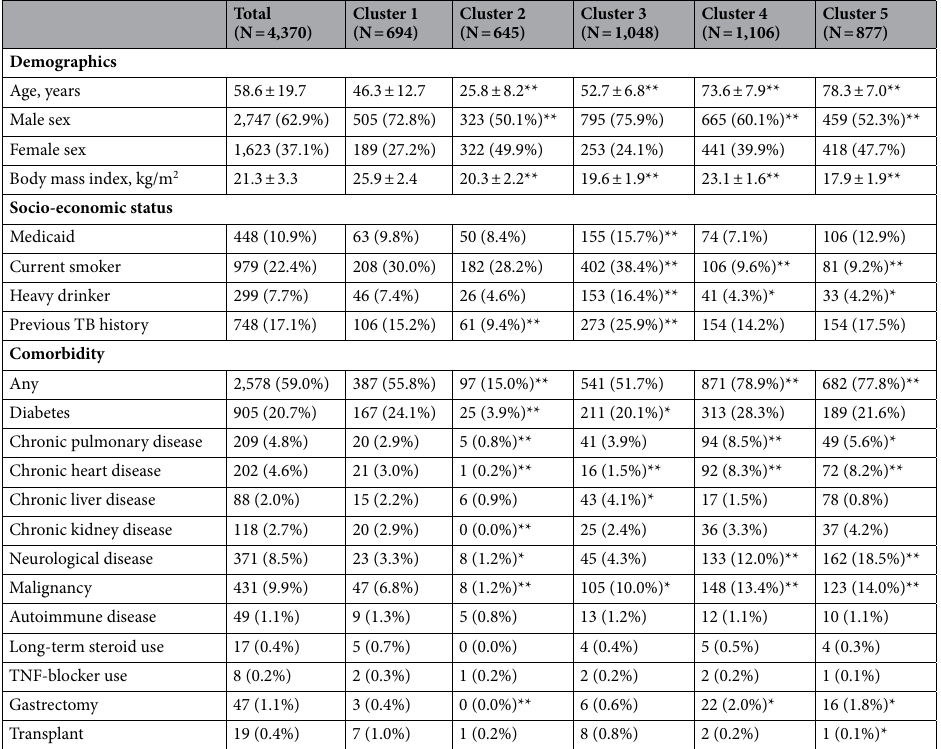
Table 1. Baseline characteristics, socio-economic profiles and comorbidities in the entire study population and among clusters in patients with pulmonary tuberculosis. TNF, tumour necrosis factor. *indicate statistical significance of P < 0.05. **indicate statistical significance of P < 0.01 compared to reference group of cluster